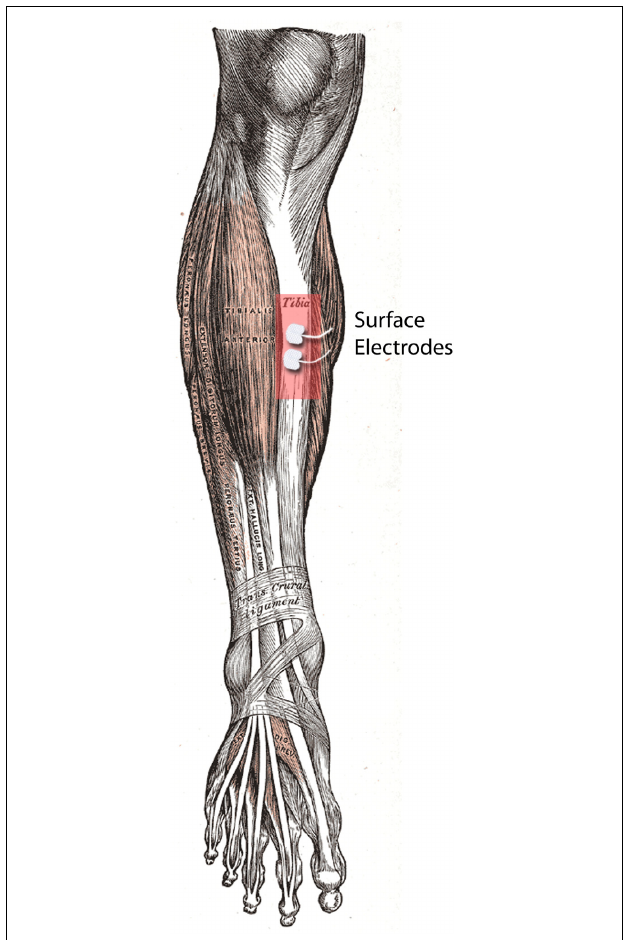
the perception of pain to be “pricking” were excluded from the